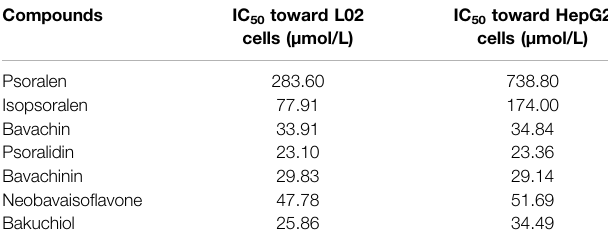
TABLE 2 | The IC 50 values of all compounds.